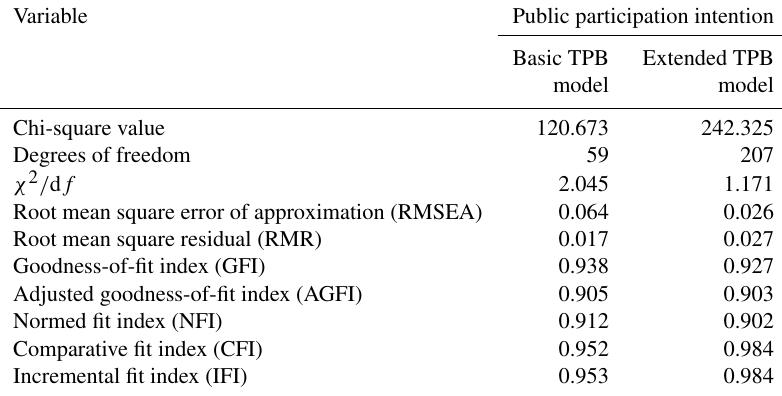
Table 4. Overall model fit